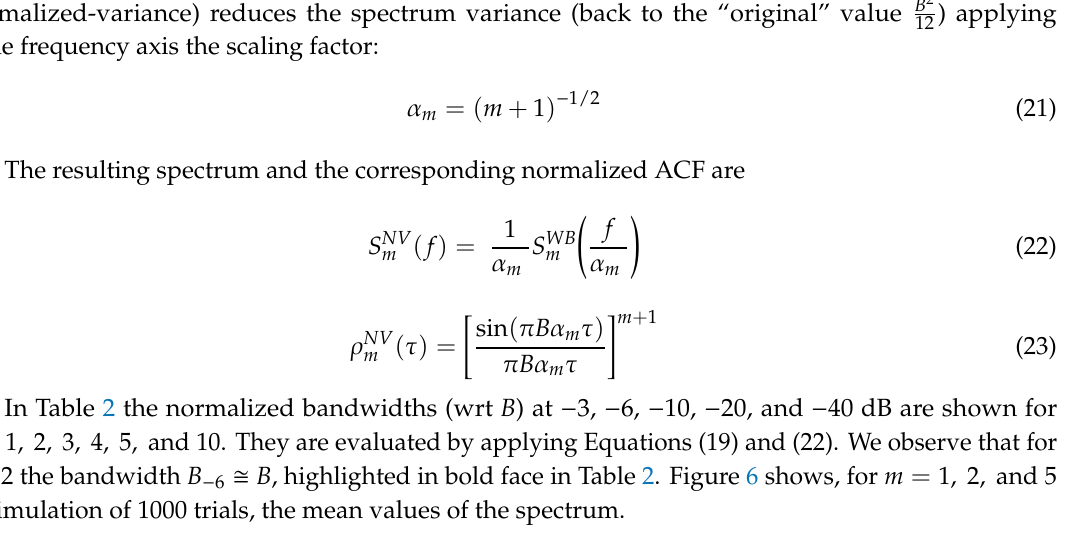
Table 2. Normalized bandwidth ( − 3, − 6, − 10, − 20, and − 40 dB) of the spectrum for “NV” waveforms. “NV” Waveforms